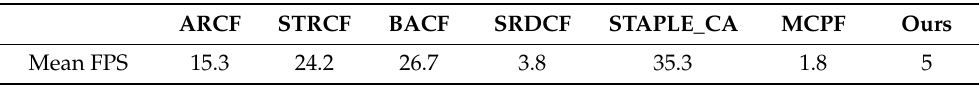
Table 1. The mean FPS results of the proposed trackers with several mainstream tracking methods on OTB-2015.